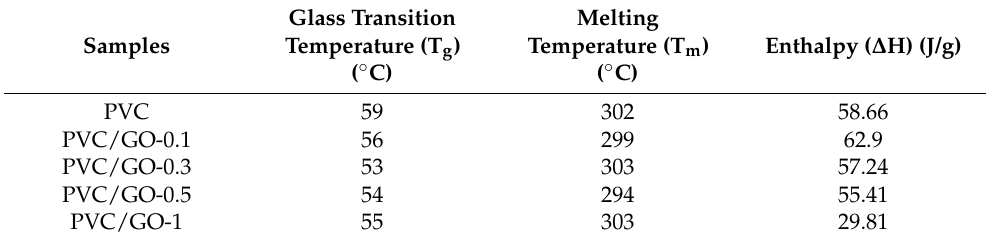
Table 6. Glass transition temperature and melting parameters of neat PVC and PVC/GO compos- ites [81]. (Adapted with permission from ref. [81]. Copyright 2015 Scientific Technical Union of Mechanical Engineering.)